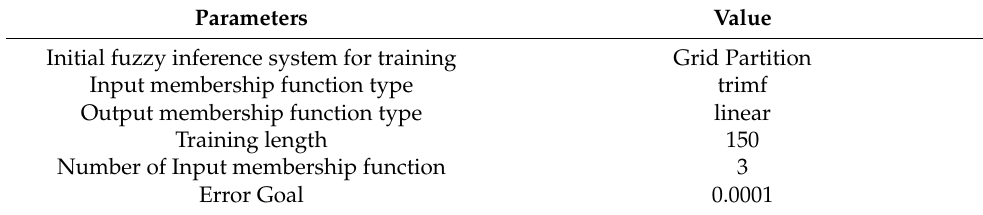
Table 1. Main parameters of ANFIS